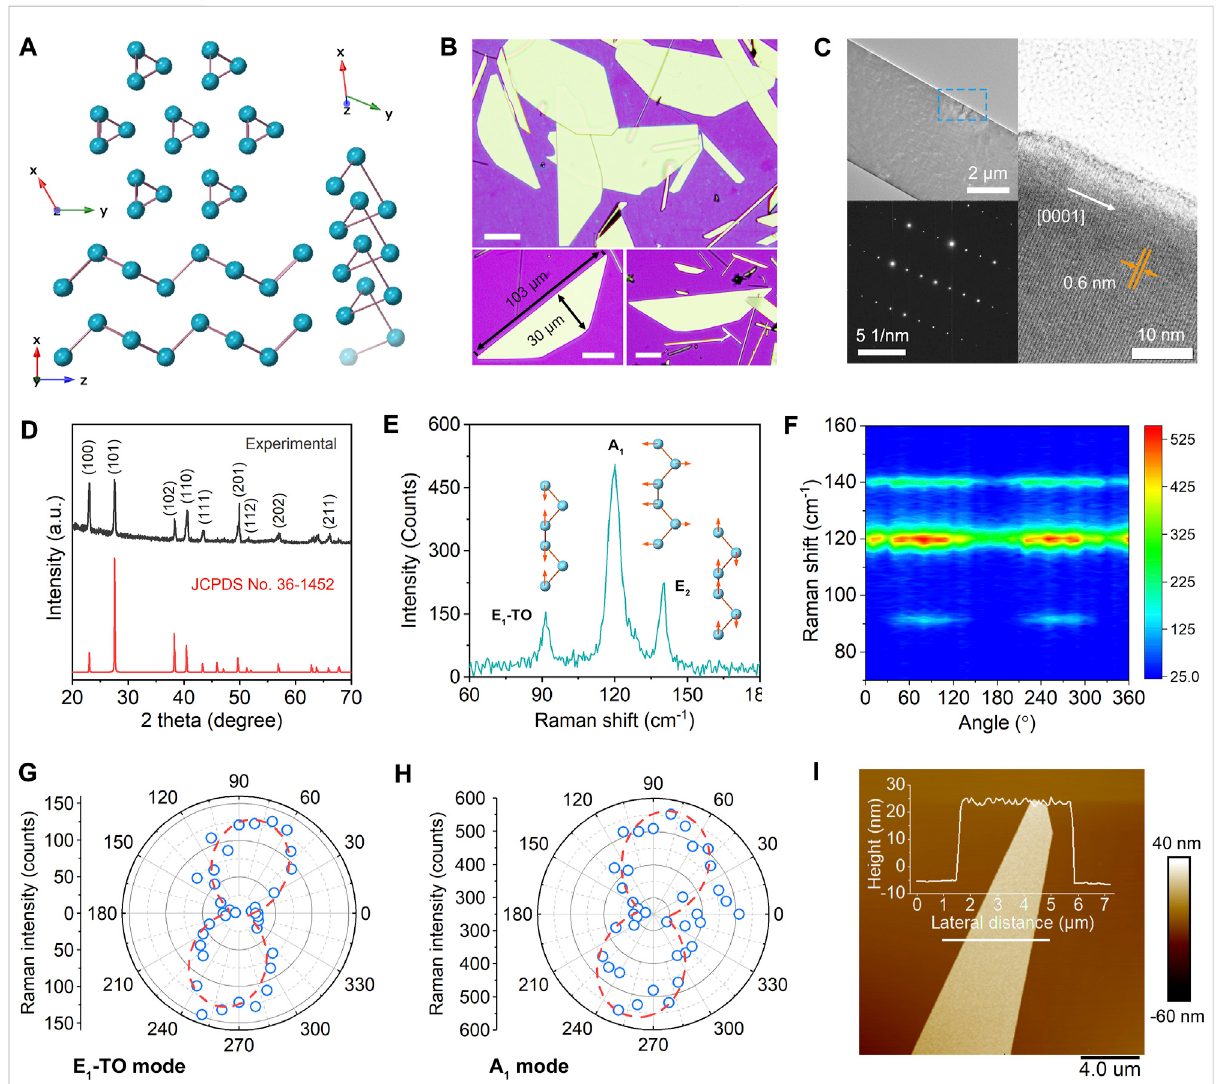
FIGURE 1 Characterizations of the solution-grown 2D Te fl akes. (A) Schematic lattice structure of trigonal Te. (B) Optical images of Te nanosheets. The scale bar is 20 μ m. (C) Low- and high-magni fi cation TEM images of individual Te and corresponding selected area diffraction pattern, evidencing its single crystallinity and growth direction along the c-axis. (D) XRD pattern of synthetic Te. (E) Raman spectrum that shows characteristic peaks of E 1 - TO, A 1 , and E 2 vibrational modes. (F) Angle-resolved polarized Raman mapping of Te nanosheet. Polar plots of Raman intensity for (G) E 1 -TO and (H) A 1 mode. (I) AFM image of a typical Te nanosheet, the thickness is ~30